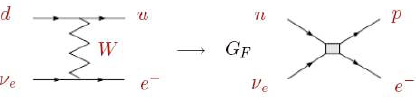
Fig. 2. Low energy beta decay mapped to